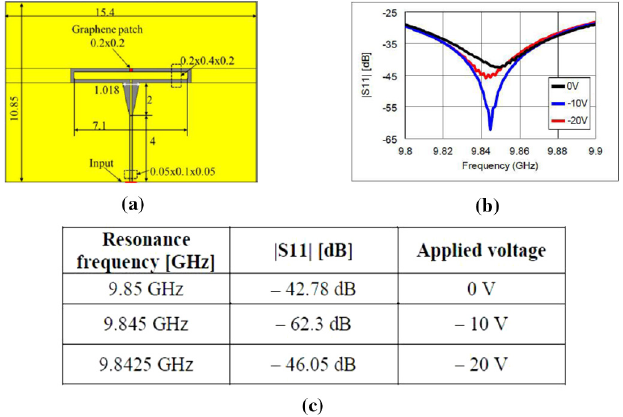
Fig. 8. (a) The con fi guration of the X band slot antenna. (b) Measured | S 11 | parameters with different bias voltages. (c) The detailed | S 11 | parameters with different bias voltages of the center frequency points.